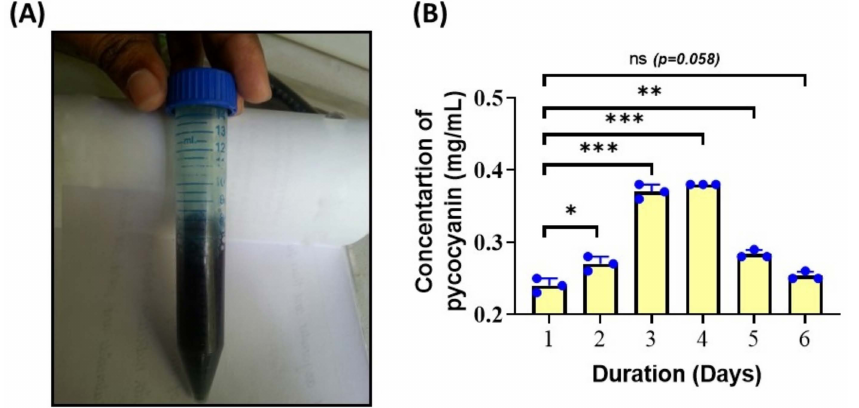
Figure 5. Extraction of phycocyanin and determination of its concentration ( A ) Picture shows the homogenized and centrifuged freeze-thawed culture of Spirulina sp. ( B ) Graph shows the concentration of Phycocyanin at different days of cultivation of Spirulina sp. * p < 0.05; ** p < 0.01; *** p < 0.001 and ns: not significant. The student’s t -test was used for